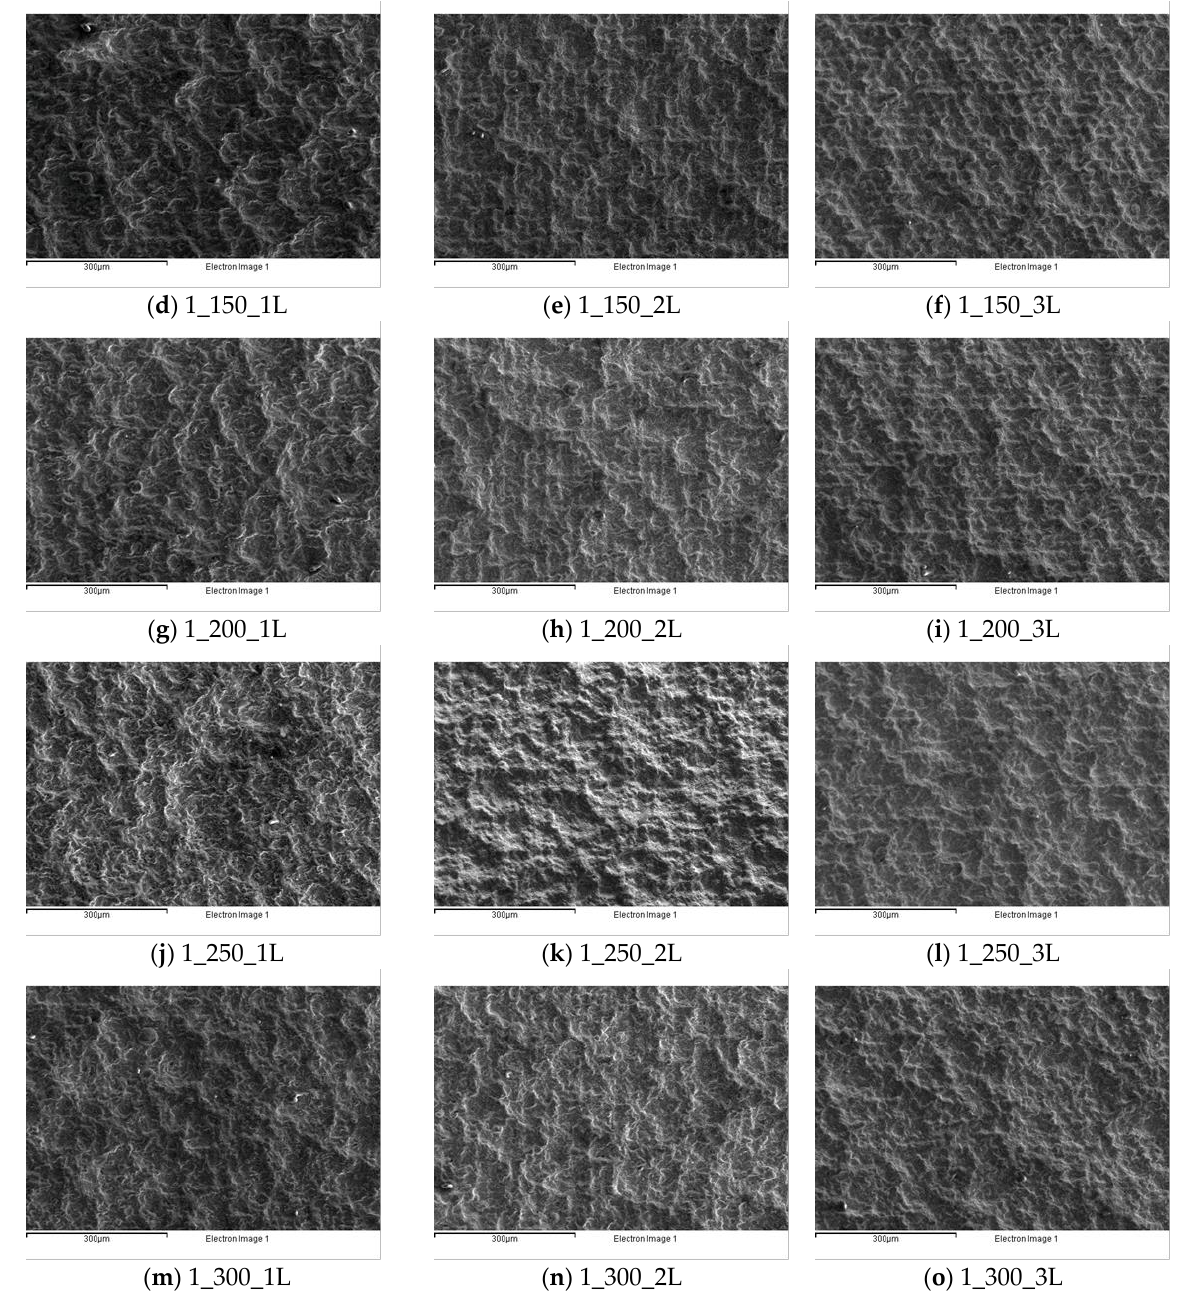
Figure 4. Morphological analysis for the first experimental series. ( a ) 1_100_1L; ( b ) 1_100_2L; ( c ) 1_100_3L; ( d ) 1_150_1L;